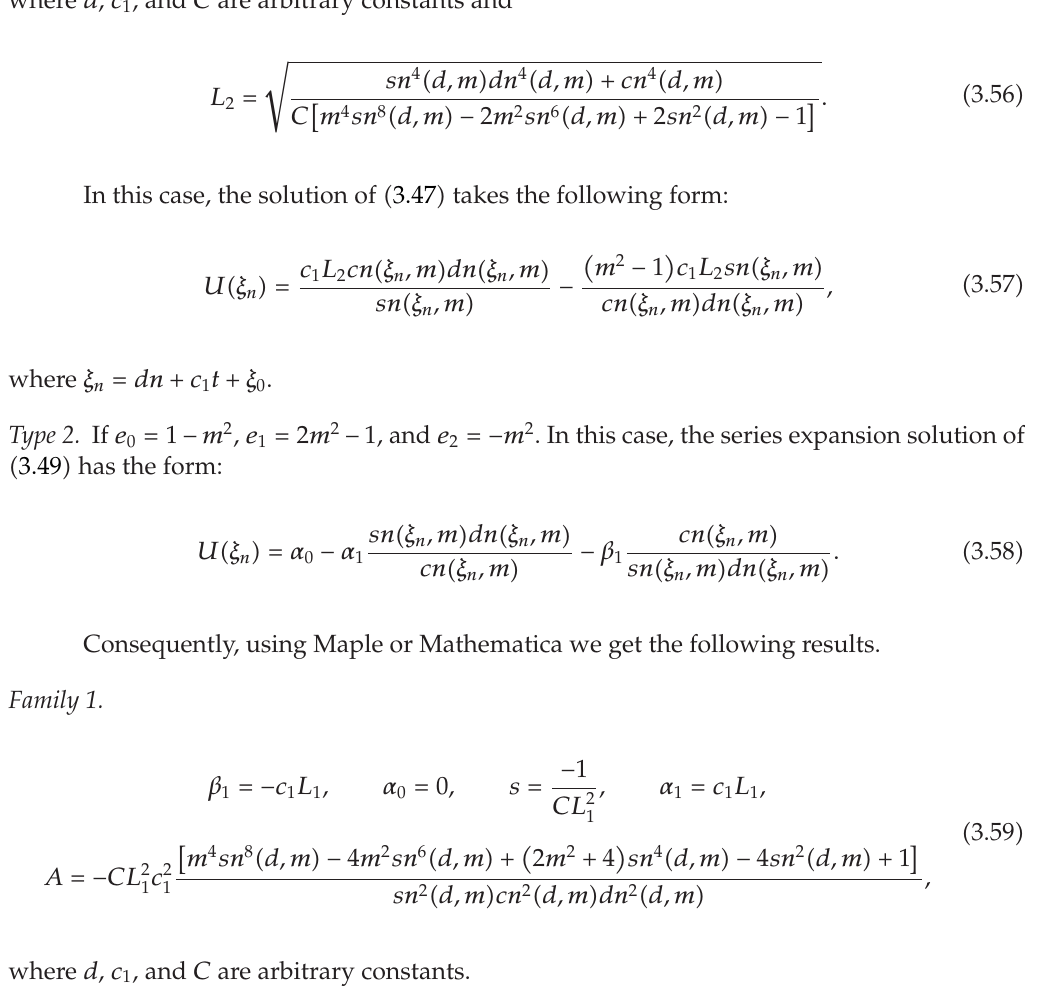
(cid:9) 0 . 4, C (cid:9) − 0 . 6, d (cid:9) 0 . 3, t (cid:9) 1 . 1